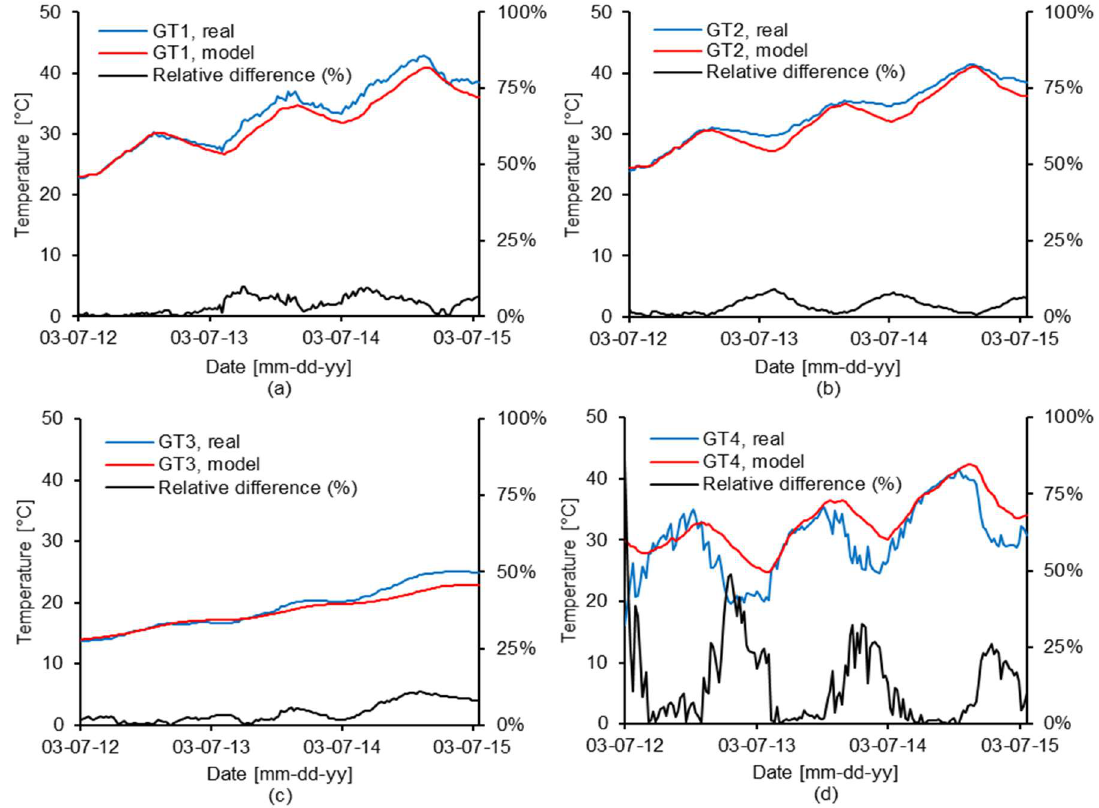
Figure 9. Ground temperatures, calculated versus measured: ( a ) GT1, ( b ) GT2, ( c ) GT3, and ( d ) GT4. The relative difference between measured and calculated data is associated with right y-axis.